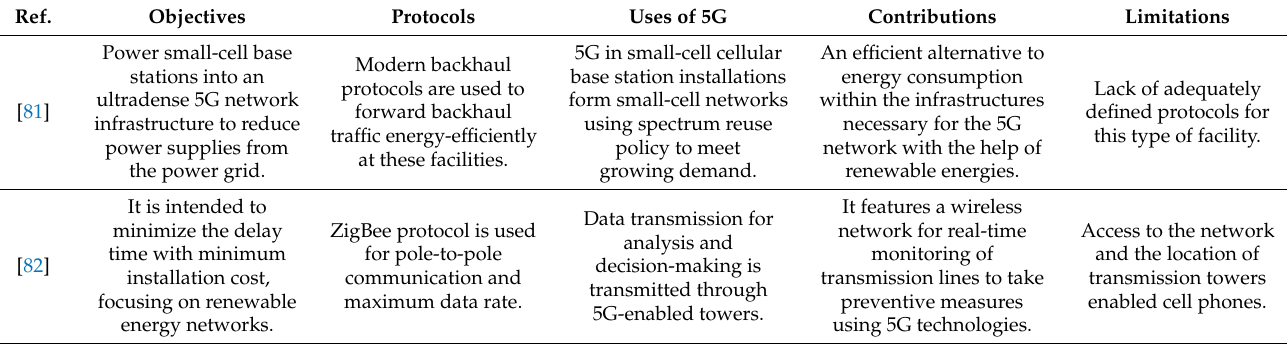
Table 3. Some microgrids use 5G management